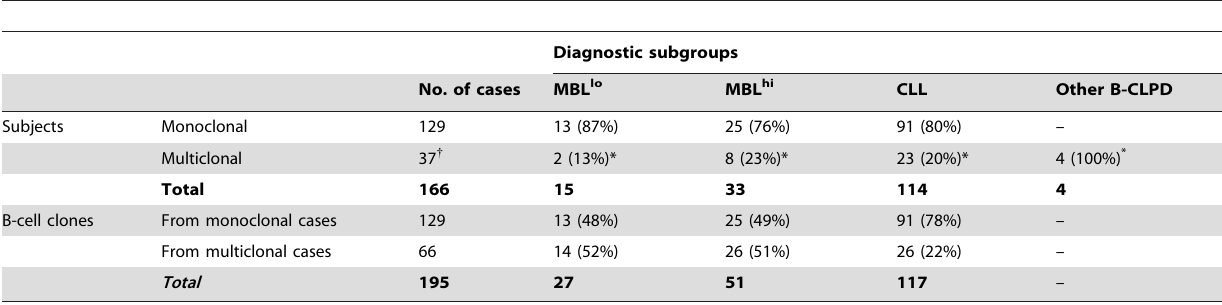
Table 1. Distribution of subjects included in the study and the corresponding CLL and CLL-like MBL clones, according to